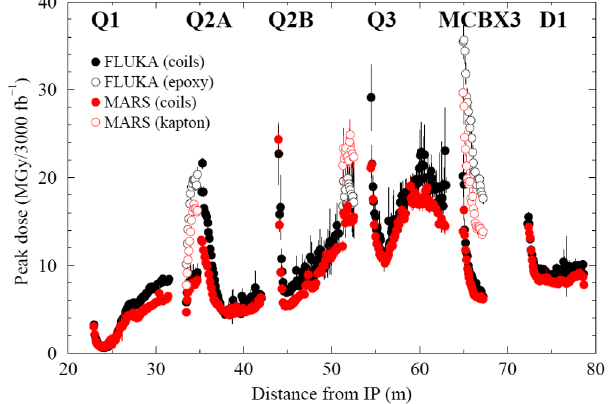
FIG. 9. Longitudinal peak dose profile on inner coils and nearby insulators.